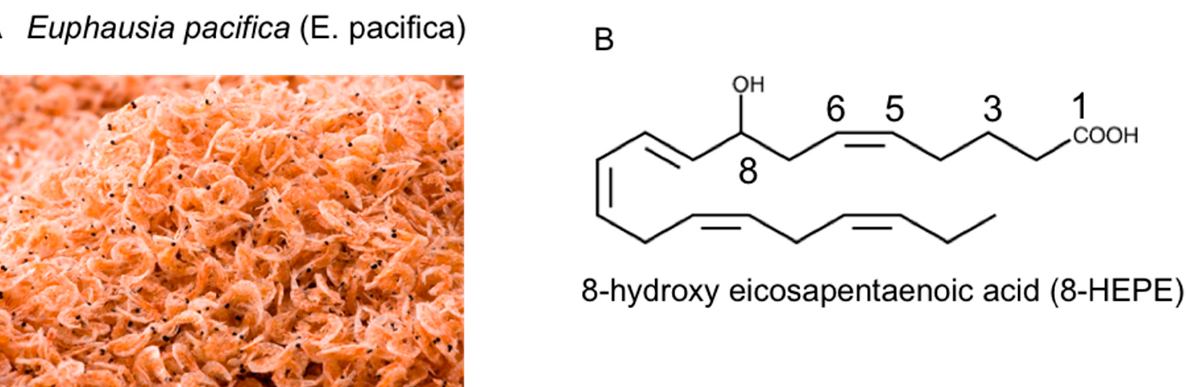
Figure 1. ( A ) Photograph of Euphausia pacifica ( E. pacifica ), also called North Pacific krill. ( B ) The structural formula of 8-hydroxyeicosapentaenoic acid (8-HEPE).